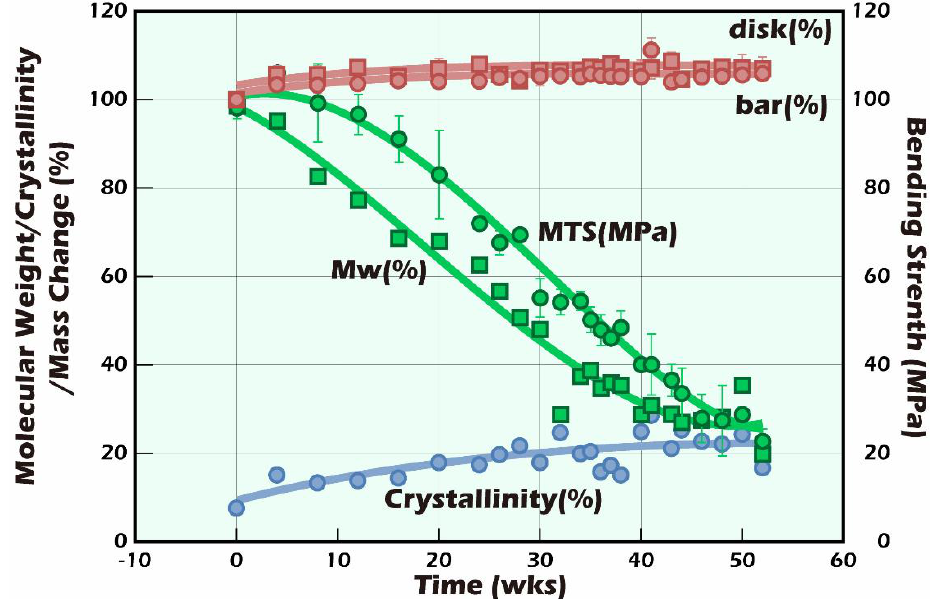
Figure 13. The variation in the partially crystalline PLLA samples in bending strength (MPa), crystallinity (%), and weight-average molecular weight (Mw) after hydrolysis in PBS for 1 – 52 weeks. MTS tested the bending strength; the gel permeation chromatography (GPC) measured Mw; and the Tc area of the DSC thermograms was used to calculate the crystallinity.